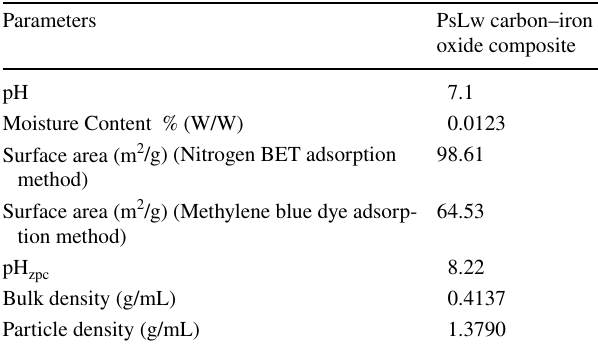
Fig. 1 Effect of